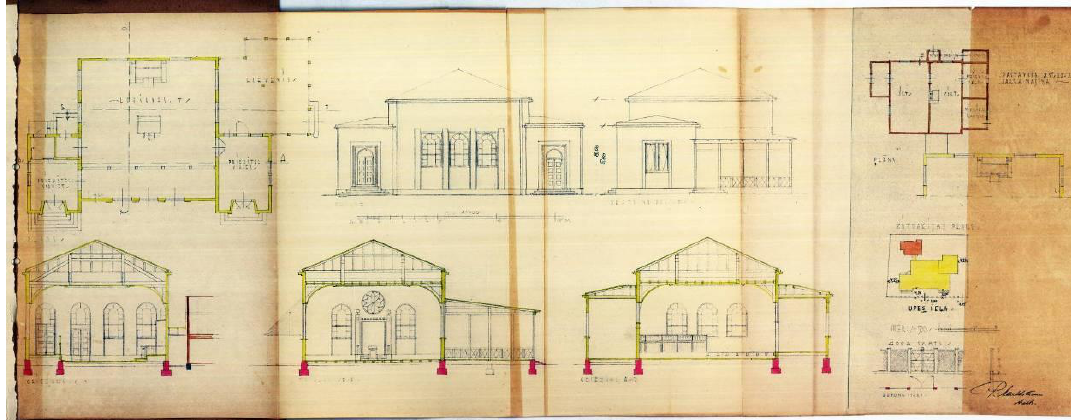
Figure 11. Design for a synagogue, in Bulduri, by Paul Mandelstamm, 1929, timber alternative. LNA LVVA. Used by Permission.